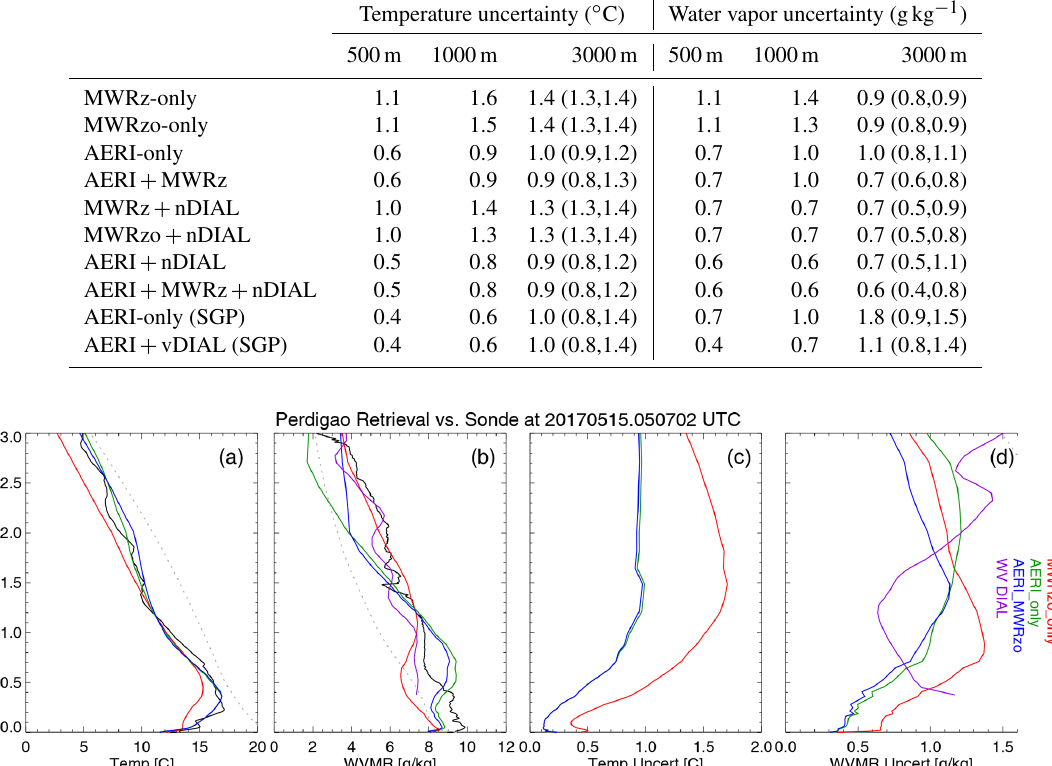
Figure 1. The retrieved profiles of temperature (a) and water vapor (b) , with the uncertainties in these profiles ( c, d , respectively), for the passive-only retrievals with the MWRzo-only (red), AERI-only (green), and AERI + MWRzo (blue) on 05:07UTC on 15 May 2017 during Perdigão. The collocated radiosonde temperature and water vapor profiles are shown in black in (a) and (b) , respectively. The water vapor observed by the DIAL and its uncertainty are included in the figure, although it is not used in any of these retrievals. The dotted black lines in (a) and (b) are the mean prior